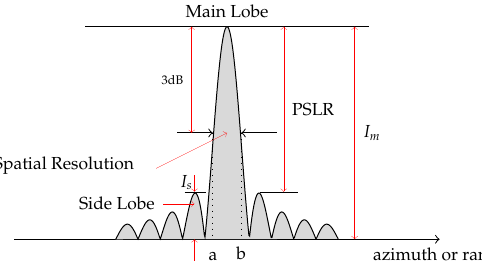
Figure 9. Impulse Response function and related